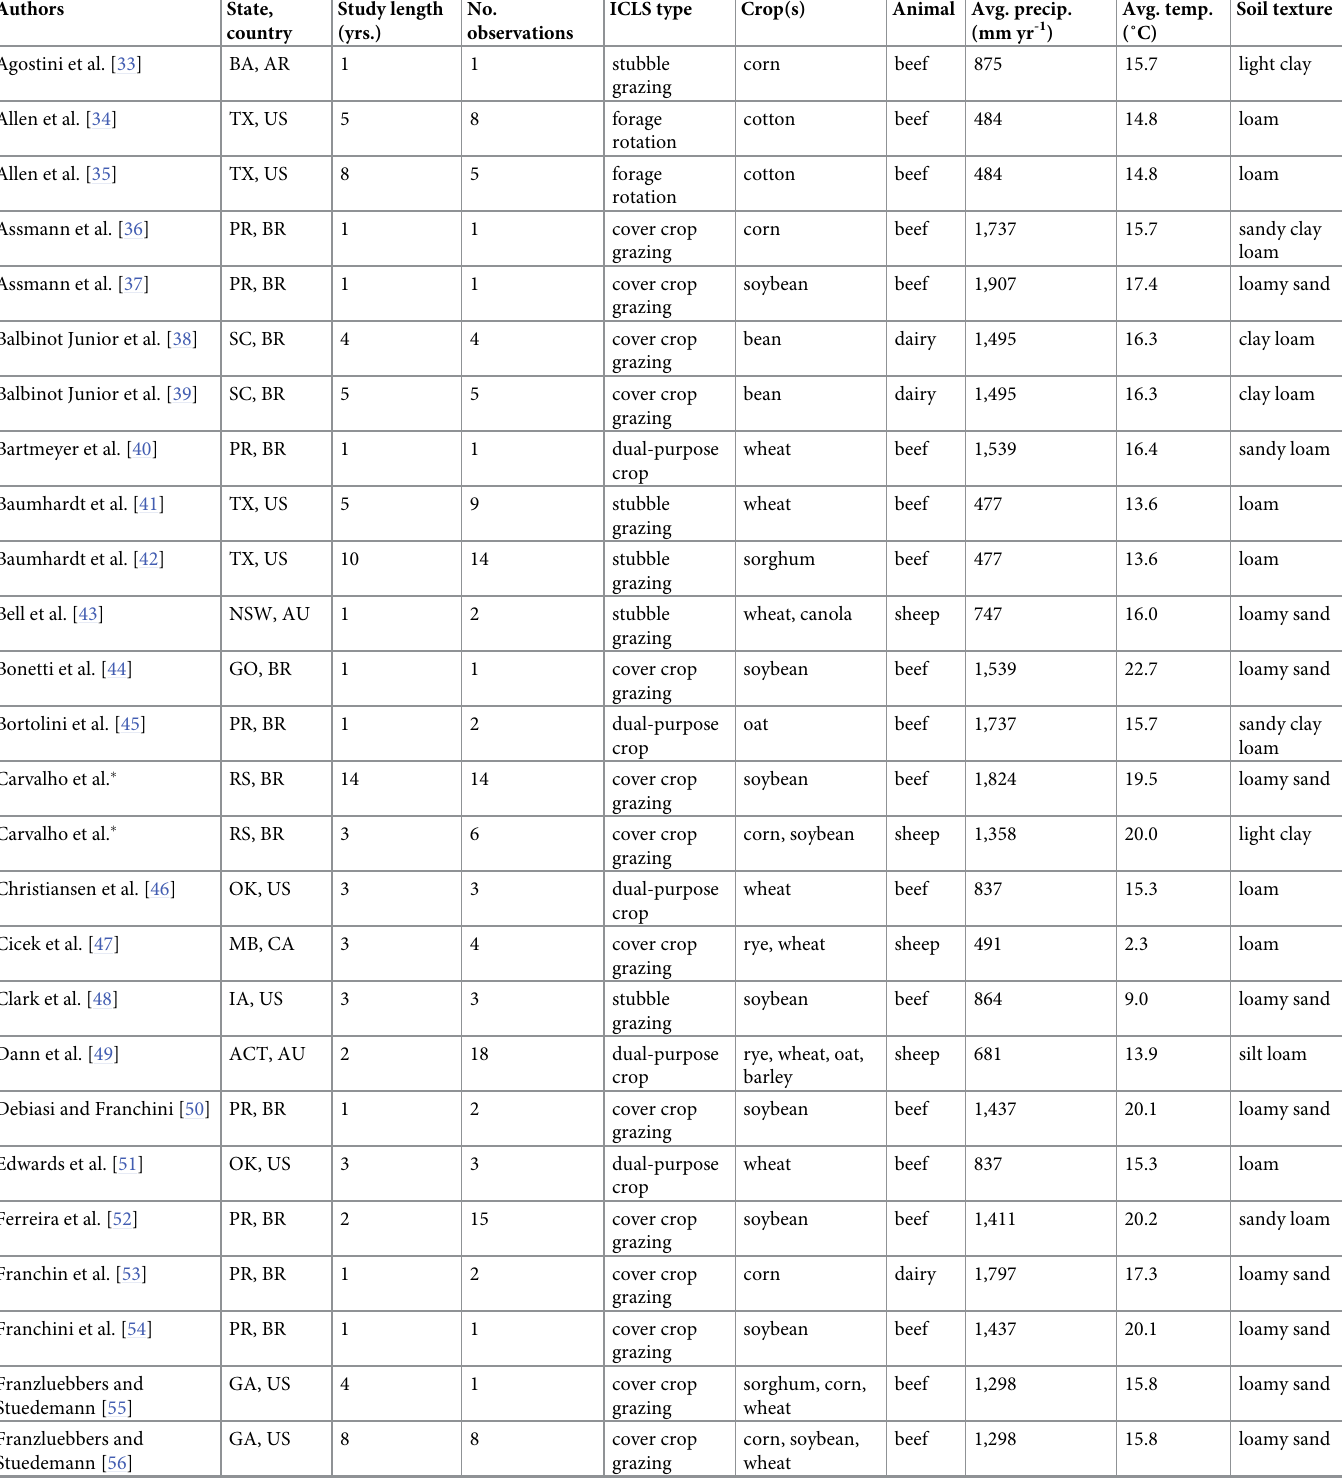
Table 1. Summary of the studies included in the meta-analysis and key environmental moderating